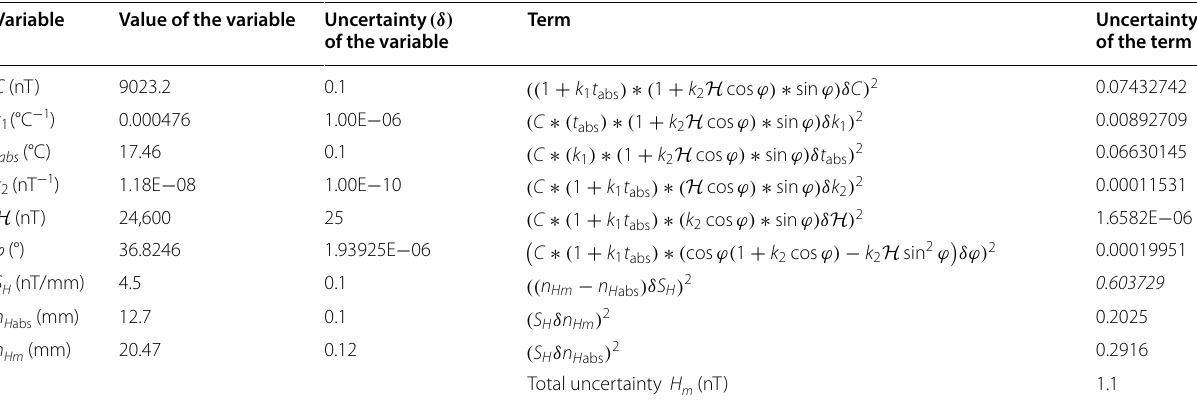
The dominant term is emphasized in italics